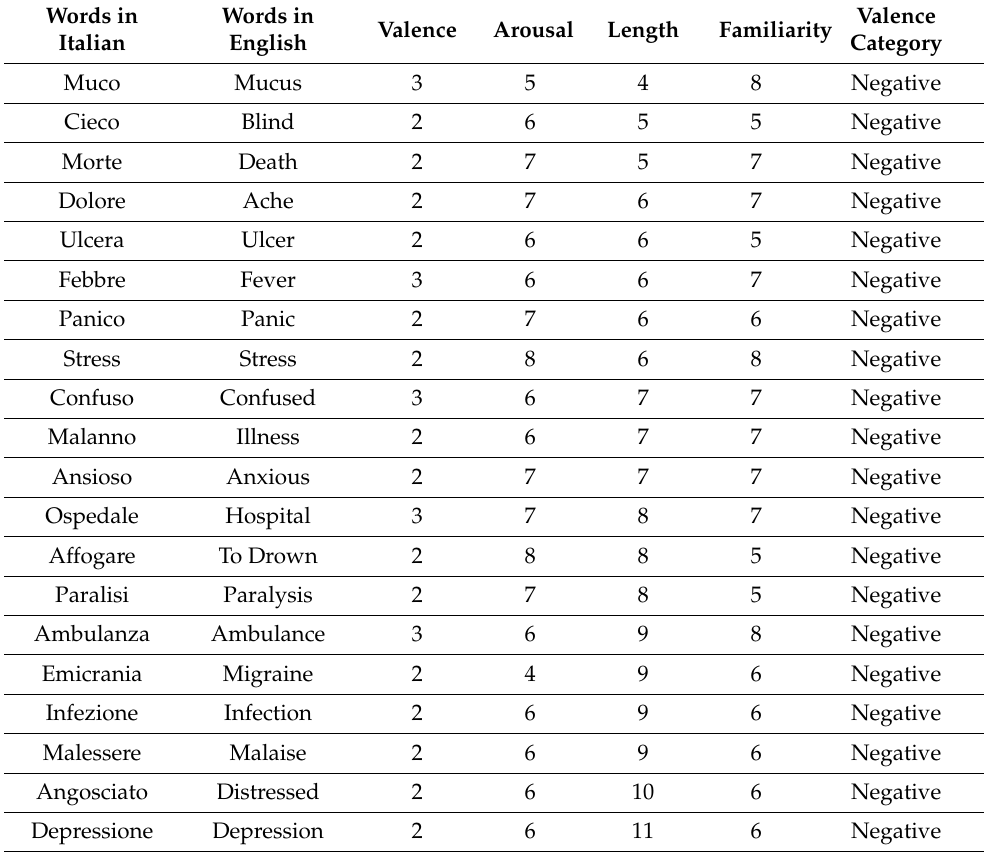
Table A1. Stimuli used in the emotional go/no-go